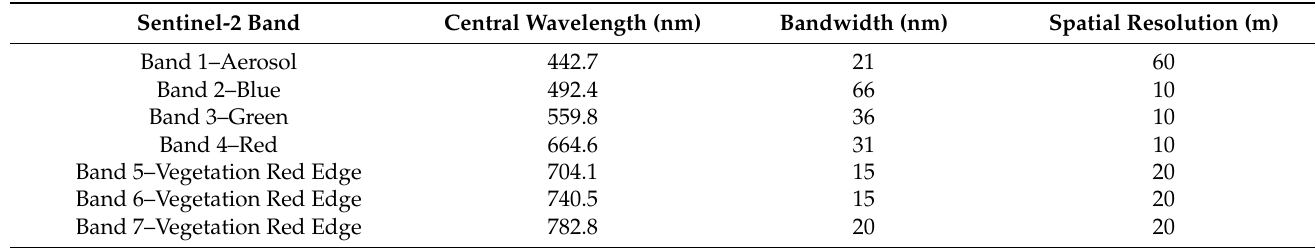
Table 1. Spectral bands for the Sentinel-2 satellite considered by the